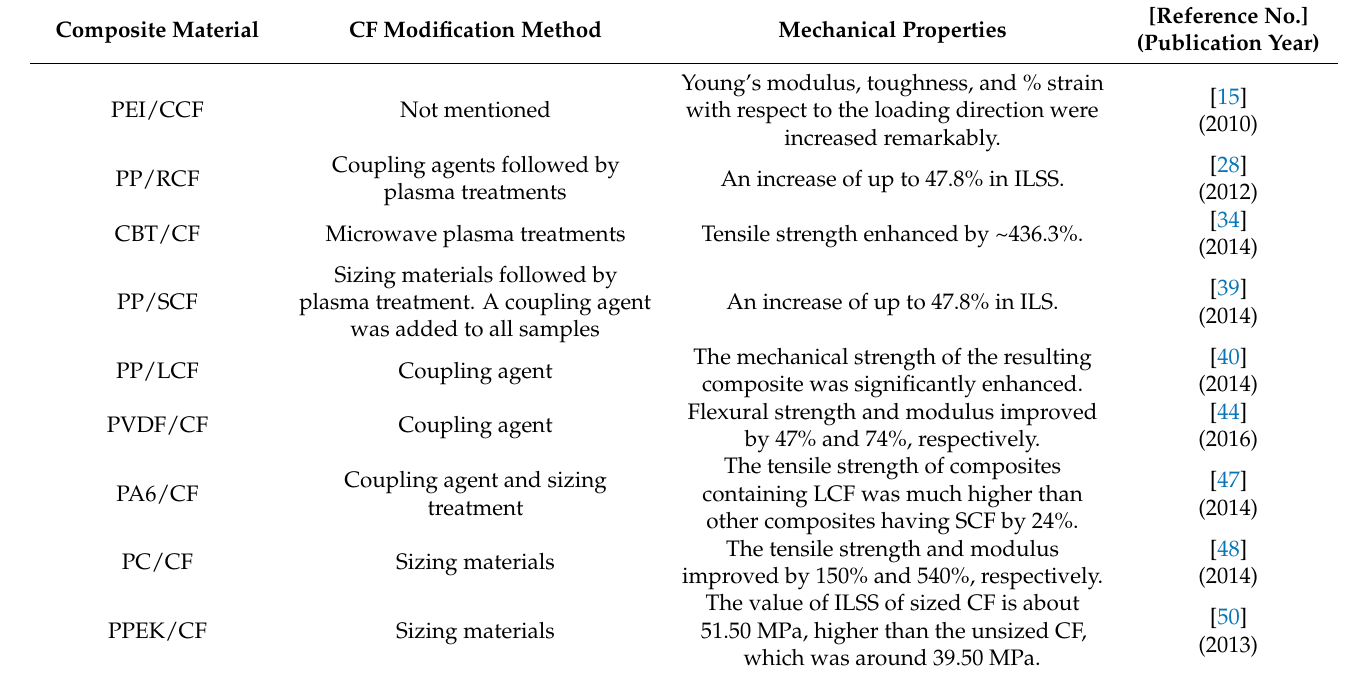
Table 2. The type of thermoplastic polymer and CF, modification techniques for CF, and mechanical properties of a variety of CFRTP